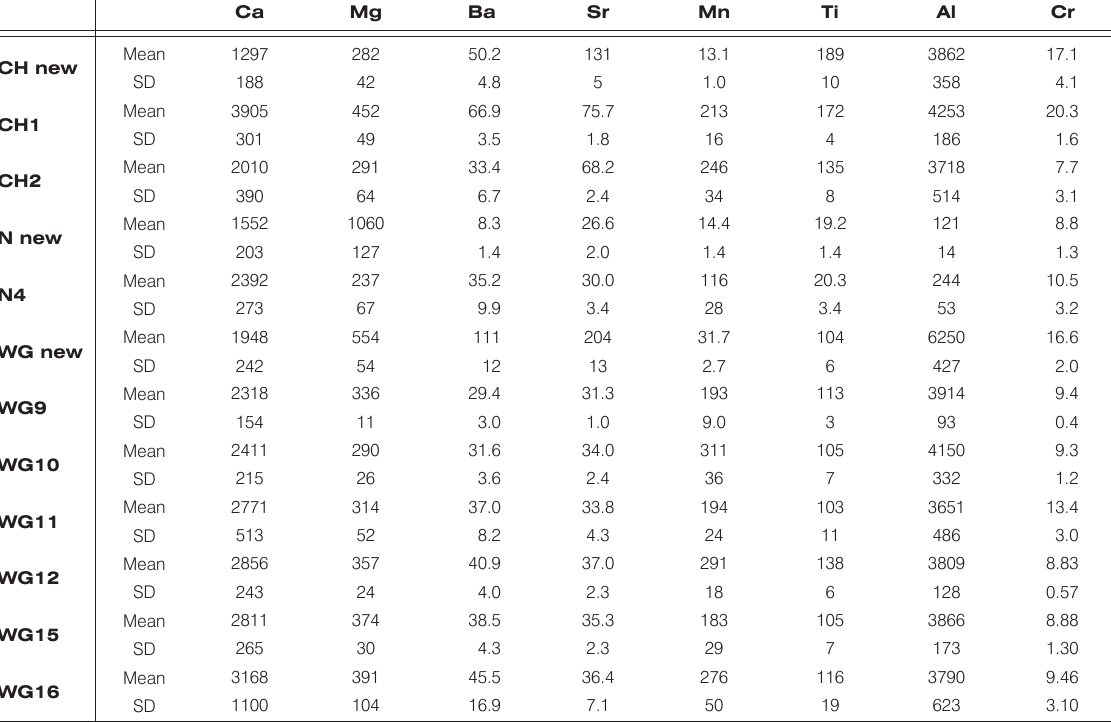
Table 3a. Mean concentration [µg g -1 ] and standard deviation for all samples of activated carbon (n = 6). Ca Mg Ba Sr Mn